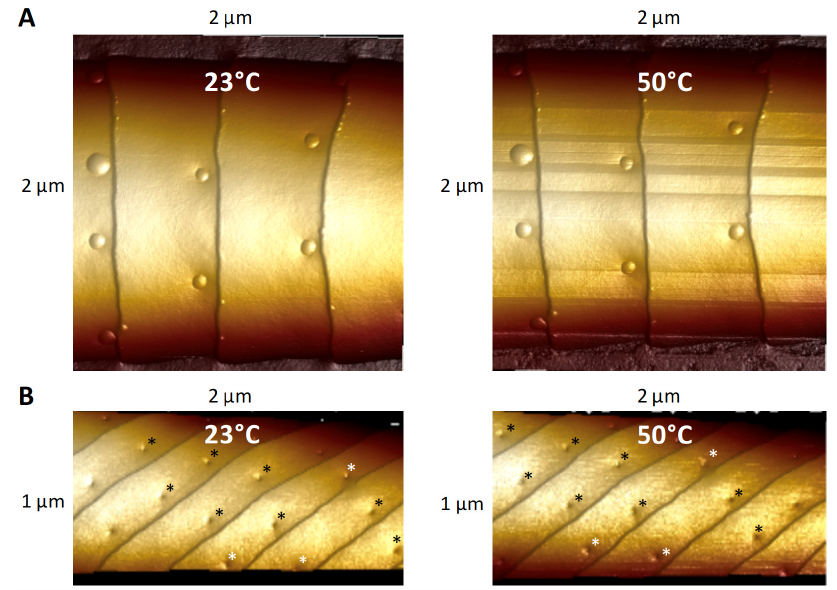
Figure 9. AFM 3D images taken from the heating experiment. ( A ) Image of a 2 µ m × 2 µ m portion of a Lymantria dispar sensillum showing domed pores at 23 ◦ C and then after heating to 50 ◦ C. No apparent changes in the domed pores are visible after heating. ( B ) Image of a 1 µ m × 2 µ m portion of a Helicoverpa zea sensillum showing open pores at 23 ◦ C and then after heating to 50 ◦ C. Pores that are labelled with black or white asterisks in the 50 ◦ C image are the same pores appearing with black or white asterisks in the 23 ◦ C image. No apparent changes in the open pores occurred after